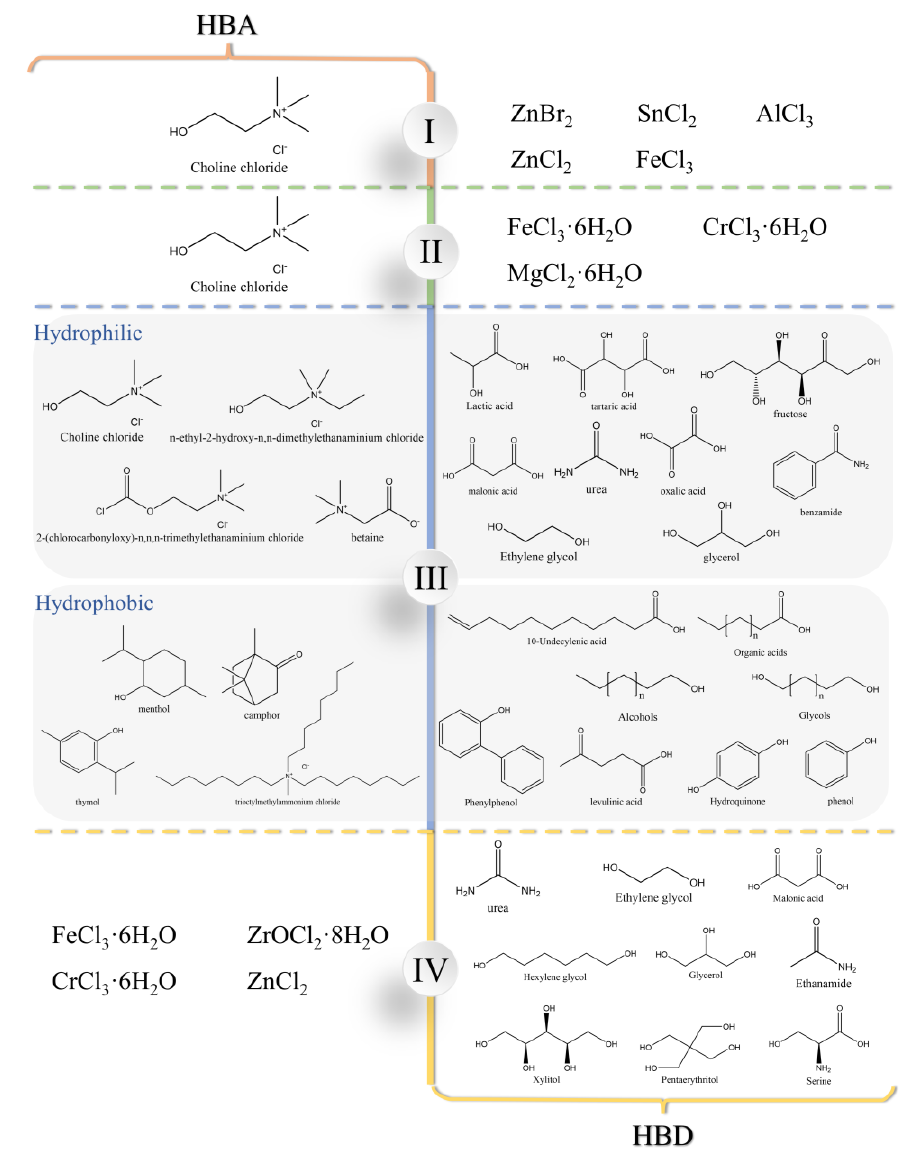
Figure 2. Classification of DESs according to their composition.